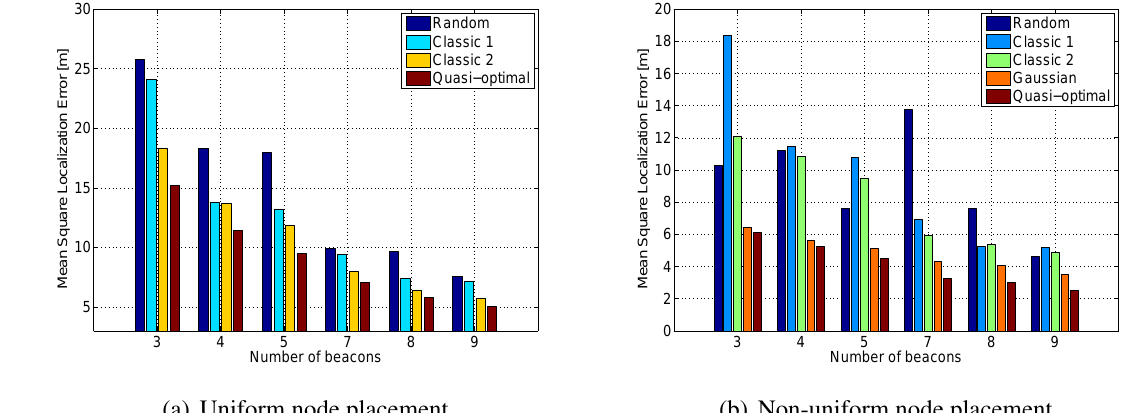
Figure 10. OMSE for different beacon deployment schemes with RSSI-based